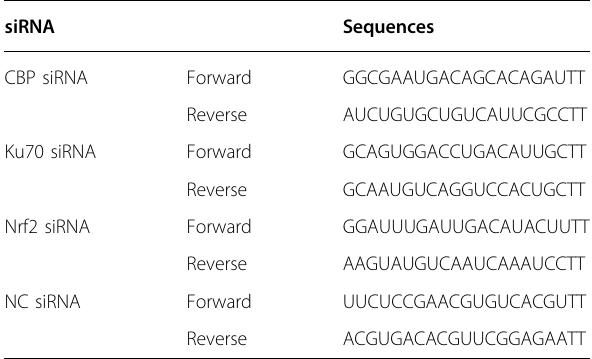
Table 1 The sequences for siRNA. siRNA Sequences